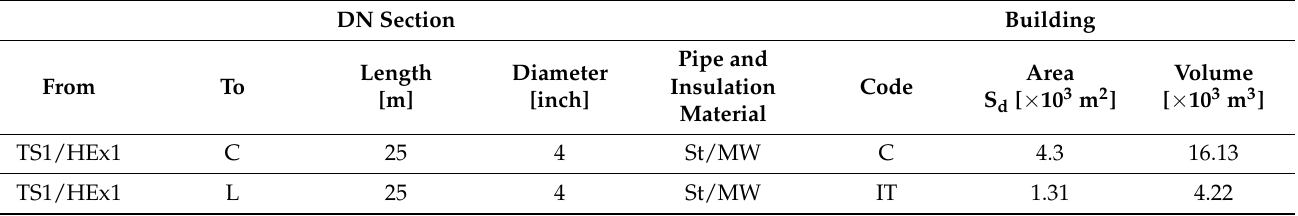
Table A1. Components of the heat distribution network and buildings involved in